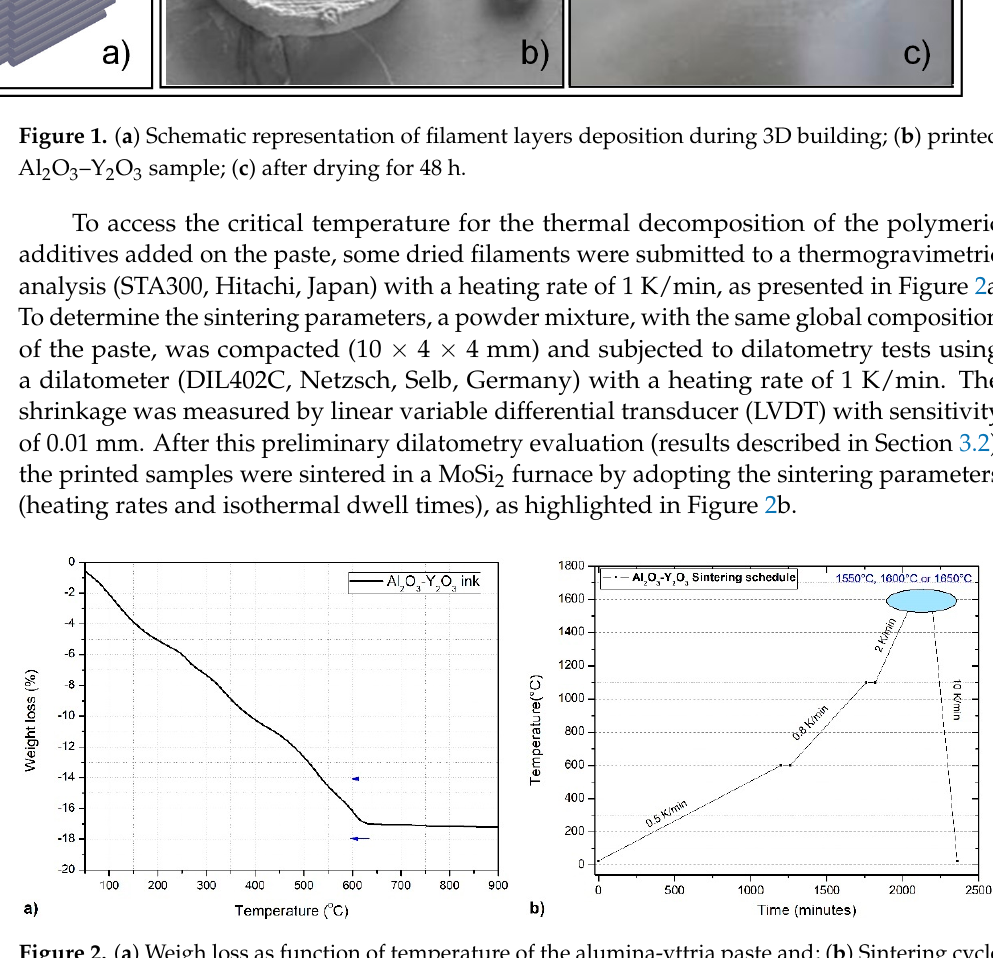
Figure 2. ( a ) Weigh loss as function of temperature of the alumina ‐ yttria paste and; ( b ) Sintering cycle adopted for densification of Al 2 O 3 –Y 2 O 3 ceramic composites obtained by DIW.